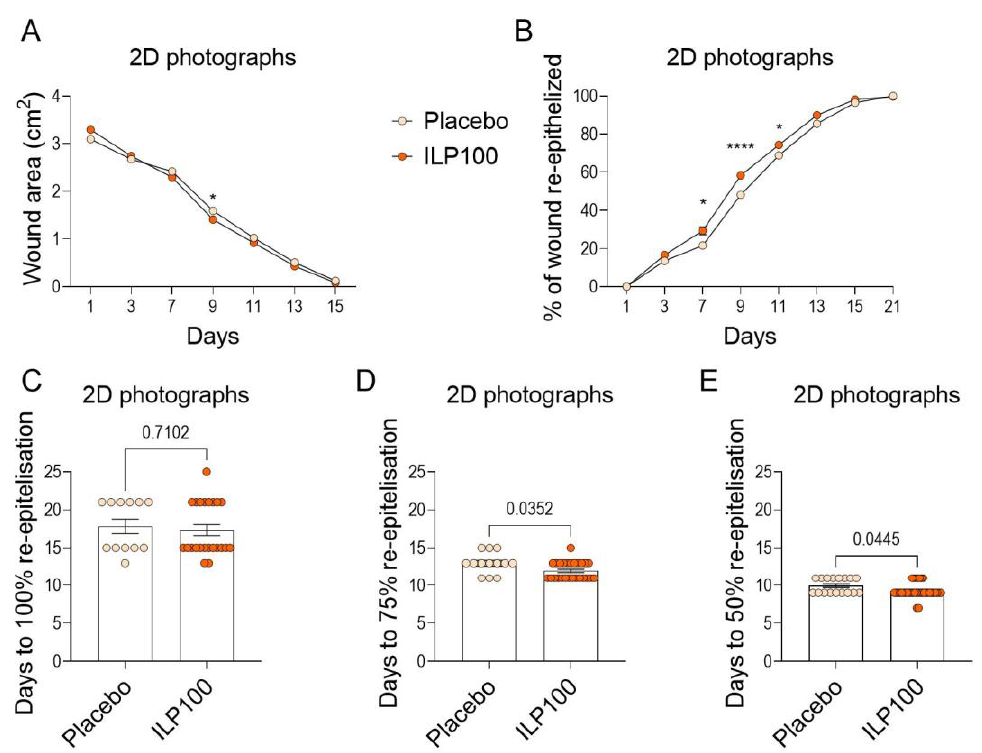
Figure A2. Wound healing assessed from 2D photographs for Cohort B. Wound area and wound healing over time measured from 2D photographs in Cohort B ( A,B ). From these measurements, days to 100% ( C ), 75% ( D ), and 50% ( E ) re-epithelization were assessed. ( A , B ); Placebo ( n = 3, N = 18), ILP100 ( n = 6, N = 36). ( C – E ): Placebo ( n = 3, N = 12–17), ILP100 ( n = 6, N = 23–35). Mann-Whitney